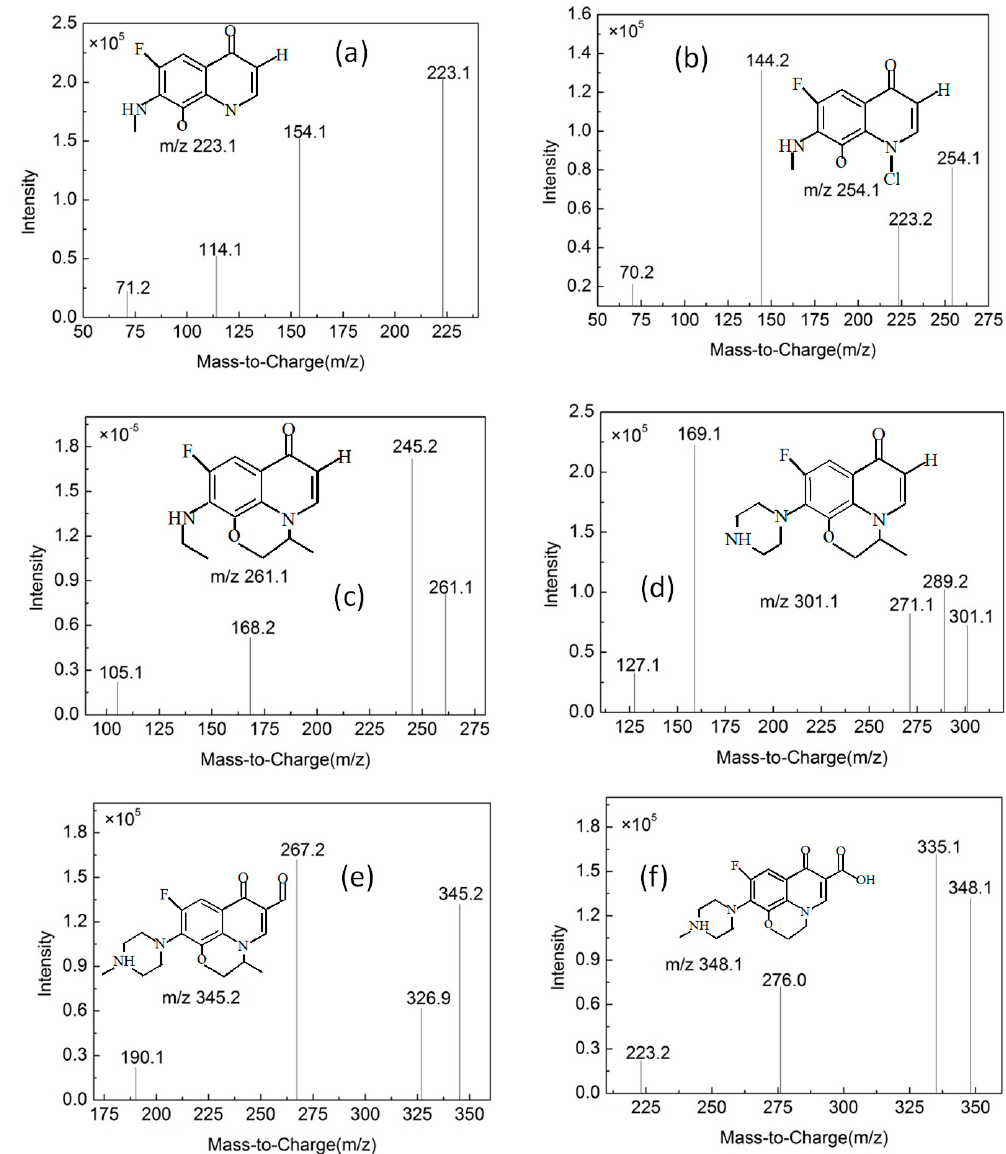
Figure 13. Mass spectrogram of the products (for details see Table 1).